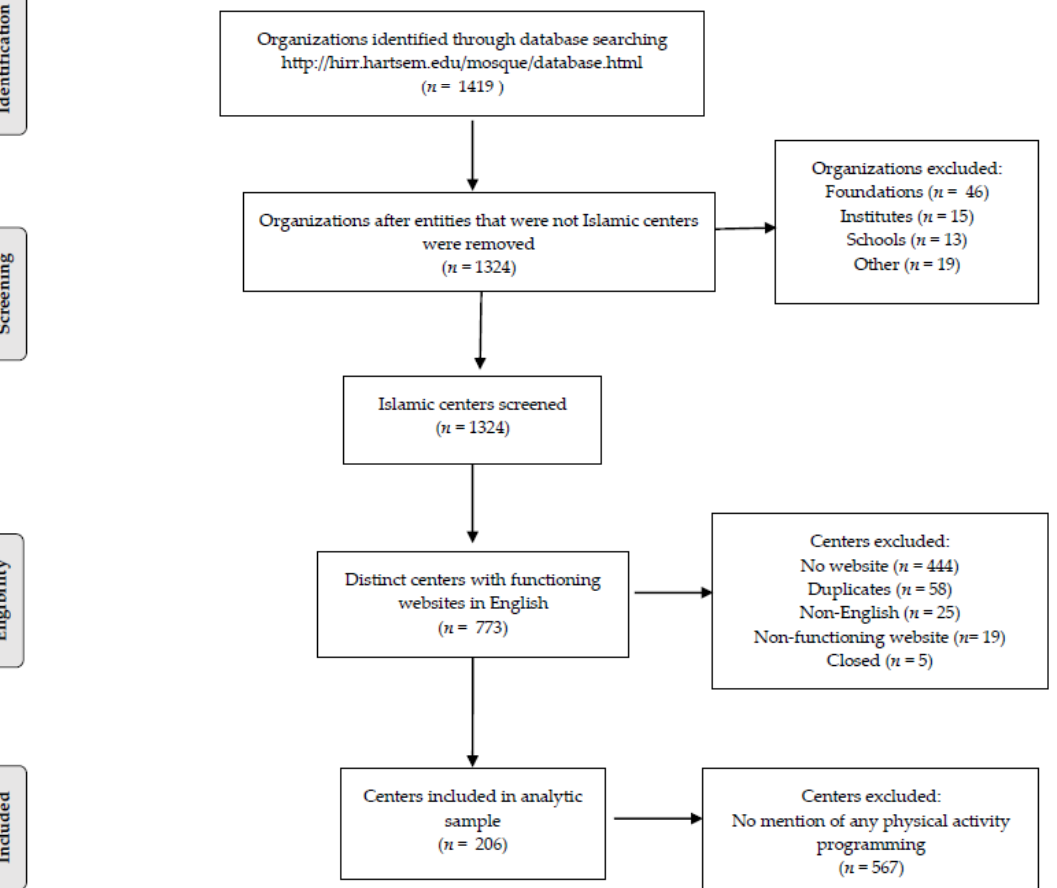
Figure 1. Flow diagram depicting steps from population of Islamic organizations to analytic sample of Islamic centers.